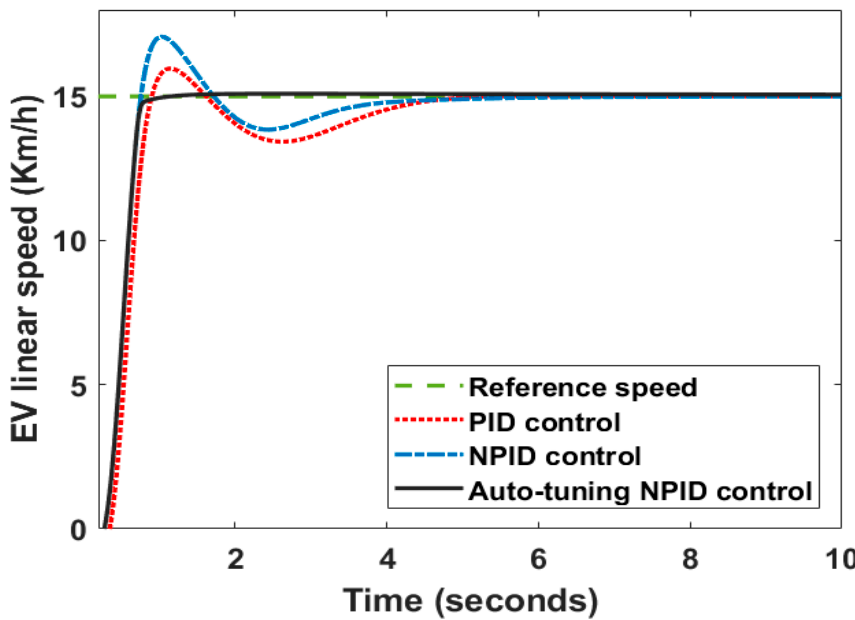
Figure 5. EV linear speed response through the proposed control techniques.